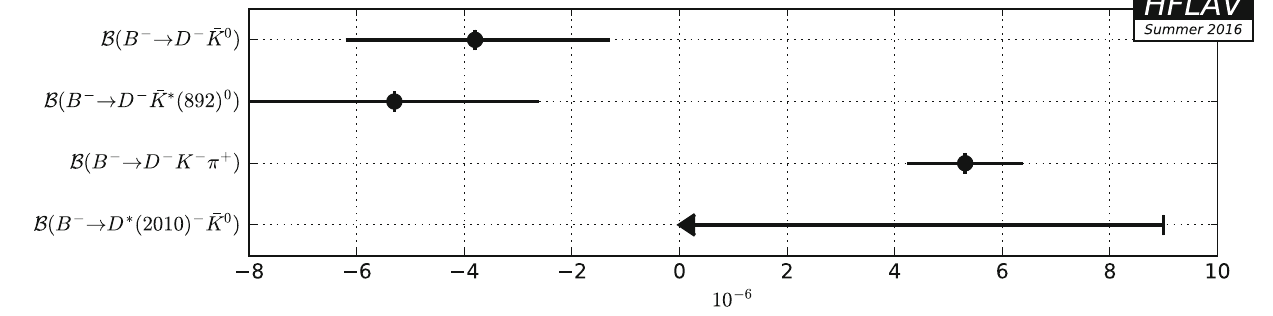
Fig. 108 Summary of the averages from Table 137